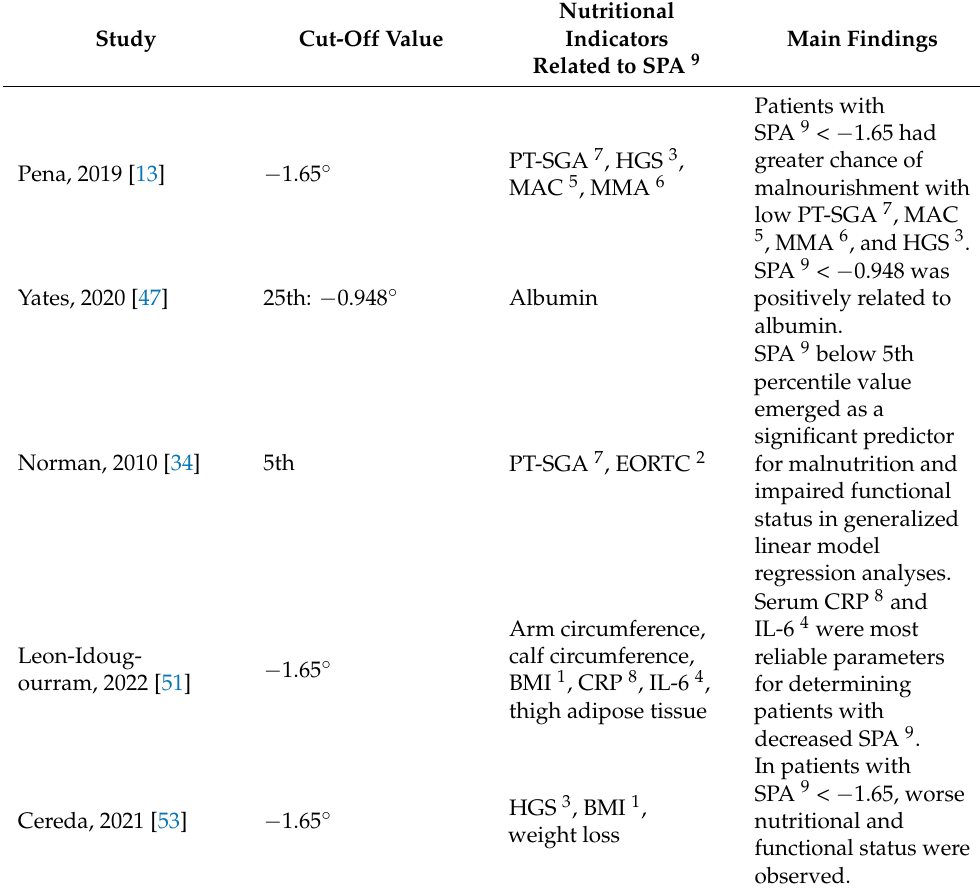
Table 4. Relationship between SPA and nutritional